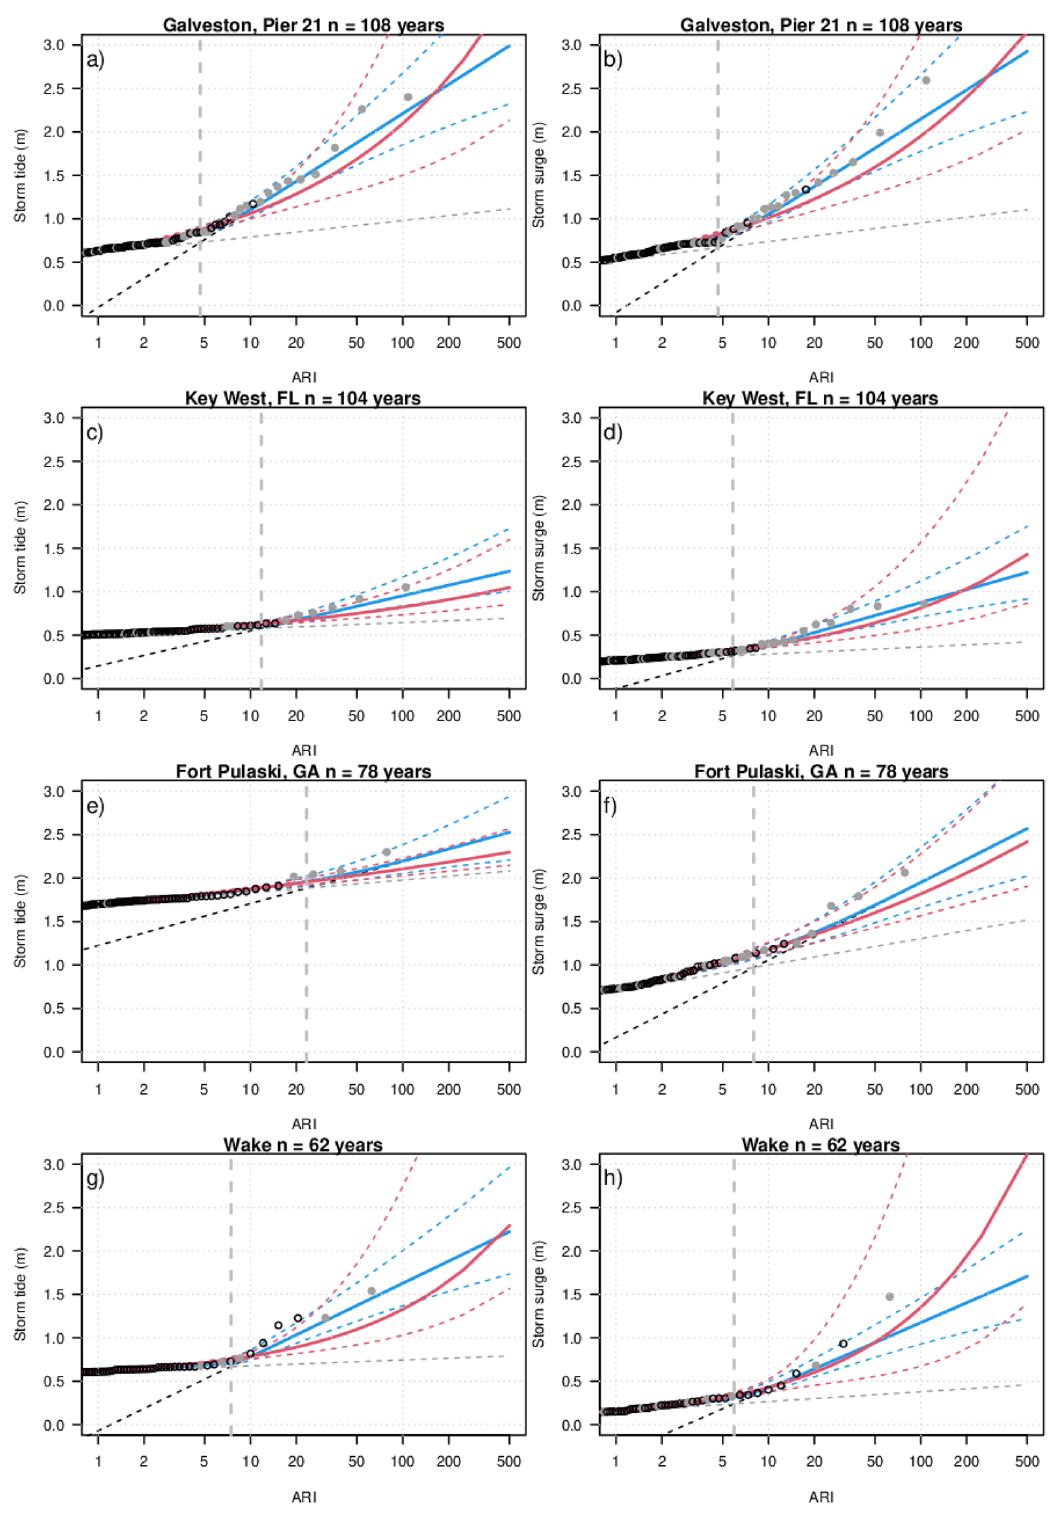
Figure 2. Tide gauge extreme storm tide (left column) and storm surge (right column). Empirically ranked annual maximum for non-TC events (black circles) and TC events (grey points) with fitted MC Gumbel (grey and black dashed lines), continuous MC (blue lines) and GEV (red lines) EVDs with 90% confidence intervals (dashed curves). Vertical thick grey dashed line indicates the intersection of the two MC Gumbel